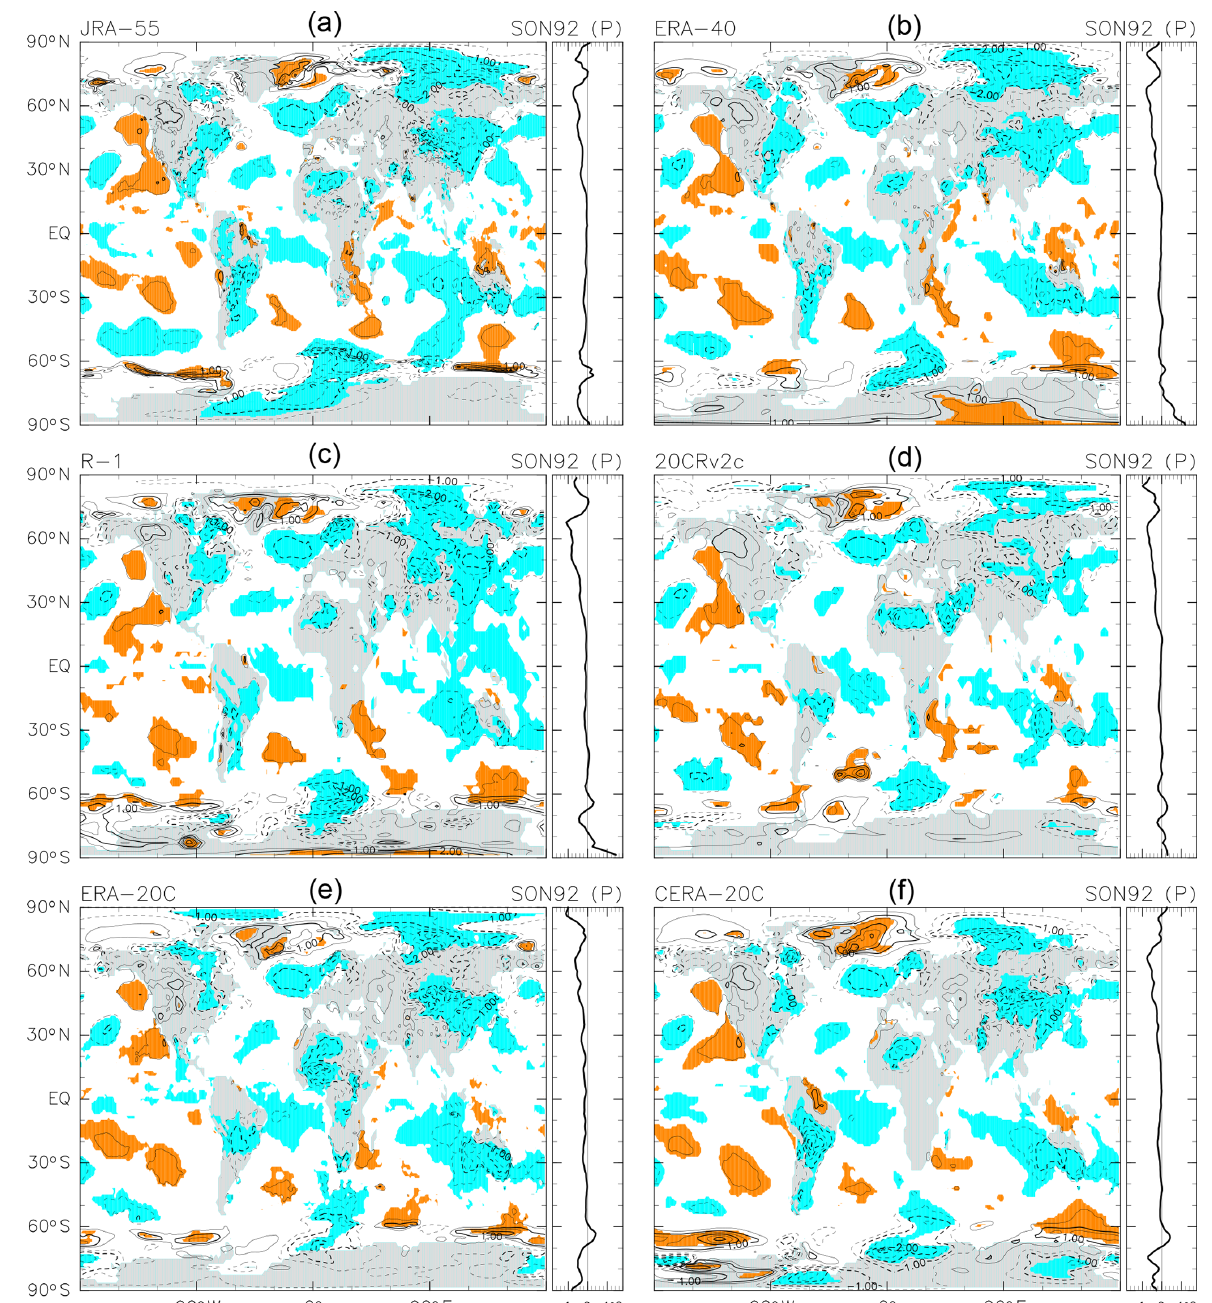
Figure 6. As for Fig. 2, but based on the 1958–2001 MLR analysis for each of six reanalysis data sets. The contour interval is 0.5K, without 0.0K lines. Coloured shading denotes anomalies that are positive (orange) or negative (blue) with magnitudes exceeding 1 SD of the 3-month mean R(t) at that